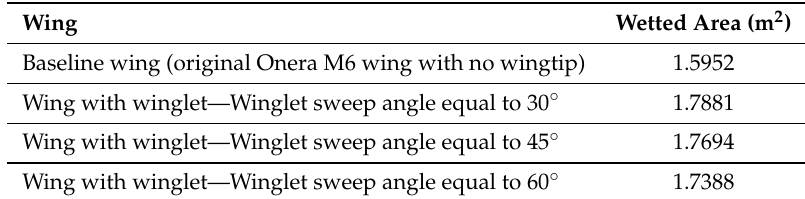
Table 2. Wetted area of each wing used in this study.